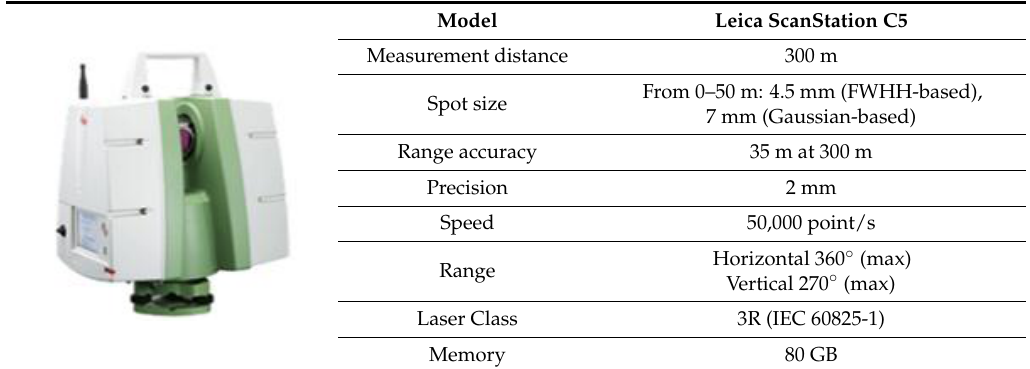
Table 3. Specifications of the terrestrial laser scanner.